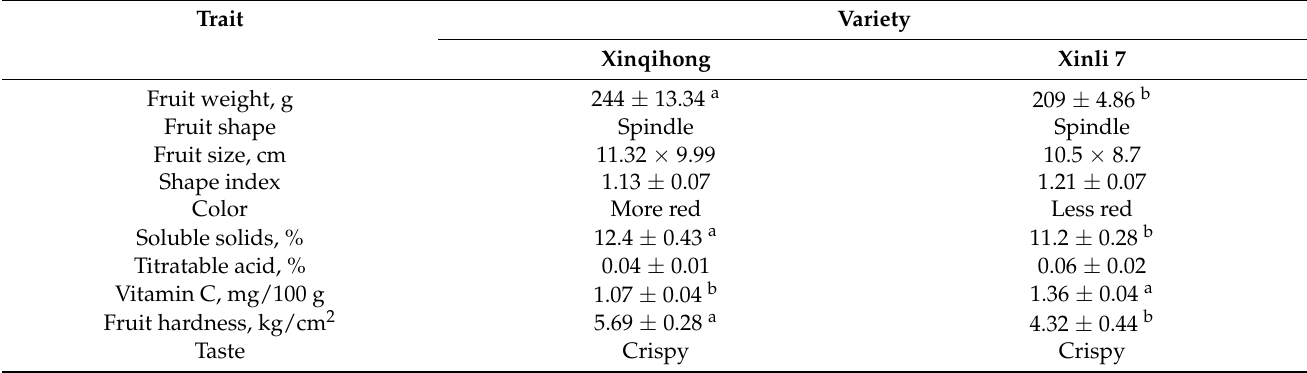
Table 1. Major intrinsic quality traits of ‘Xinqihong’ and ‘Xinli 7 (cid:48) red pear varieties. Trait